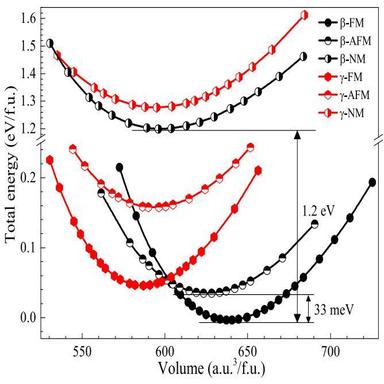
The total energy vs. volume curves for half-Heusler VSbSr in different competing phases and magnetic states. The minimum energy b-phase in ferromagnetic state, is taken as the zero of energy.